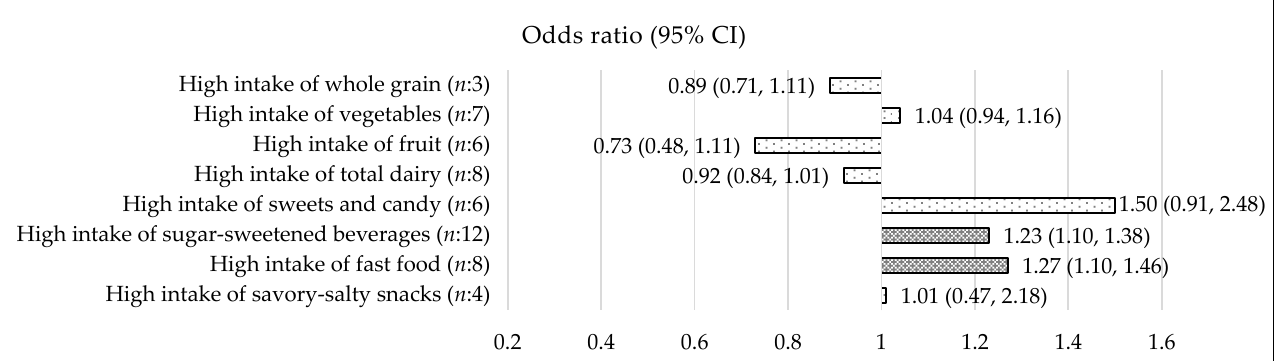
Figure 4. Association between a high intake of four different food and beverages categories and risk of overweight/obesity in adolescents 12–18 years. OR < 1 = decreased risk of overweight/obesity, OR > 1 = increased risk of overweight/obesity. Dark shades are significant ( p ≤ 0.05). White shades are not significant. The forest-plots for each food or beverages category is available in Supplementary Figures S25–S28 . Fruit: Based on 15 records [17–20,23,25,27–31,33–36], the OR (95% CI) for higher in- take of fruit compared to lower intake of fruit was 0.94 (0.84, 1.04) ( p = 0.22) ( I 2 = 72.44%) in children and adolescents 5–18 years (Figure 2). In children 5–11 years, the OR (95% CI) was 0.73 (0.48, 1.11) ( p = 0.14) ( n :6) (Figure 3) and in adolescents 12–18 years, the OR (95% CI ) was 1.04 (0.95, 1.15) ( p = 0.39) ( n :3) (Figure 4). Types of fruits investigated were not specif ied. 100% fruit and vegetables juices: Based on four records [29,37–39], the OR (95% CI) for higher intake of 100% fruit and vegetable juices versus lower intake of 100% fruit and vegetable juices was 1.05 (0.76, 1.46) ( p = 0.77) ( I 2 = 78.61%) in children and adolescents 5– 18 years (Figure 2). 100% fruit and vegetable juices were defined as 100% orange juices, 100% fruit juices/drinks, and fruit/vegetable juice. Total dairy: Based on 16 records [17,22,25,27,28,39–49], the OR (95% CI) for higher intake of total dairy compared to lower intake of total dairy was 0.94 (0.86, 1.04) ( p = 0.26) ( I 2 = 88.50%) in children and adolescents 5–18 years (Figure 2). Excluding the two outcome measure from the meta-analysis, investigating cheese specifically [22,27] did not change the results (data not shown). In children 5–11 years, the OR (95% CI) for a higher intake of total dairy compared to a lower intake of total dairy was 0.92 (0.84, 1.01) ( p = 0.08) ( n :8) (Figure 3). When excluding cheese, the OR (95% CI) for a higher intake of milk and dairy compared to a lower intake of milk and dairy was 0.90 (0.80, 1.00) ( p = 0.06) ( n :7) (see